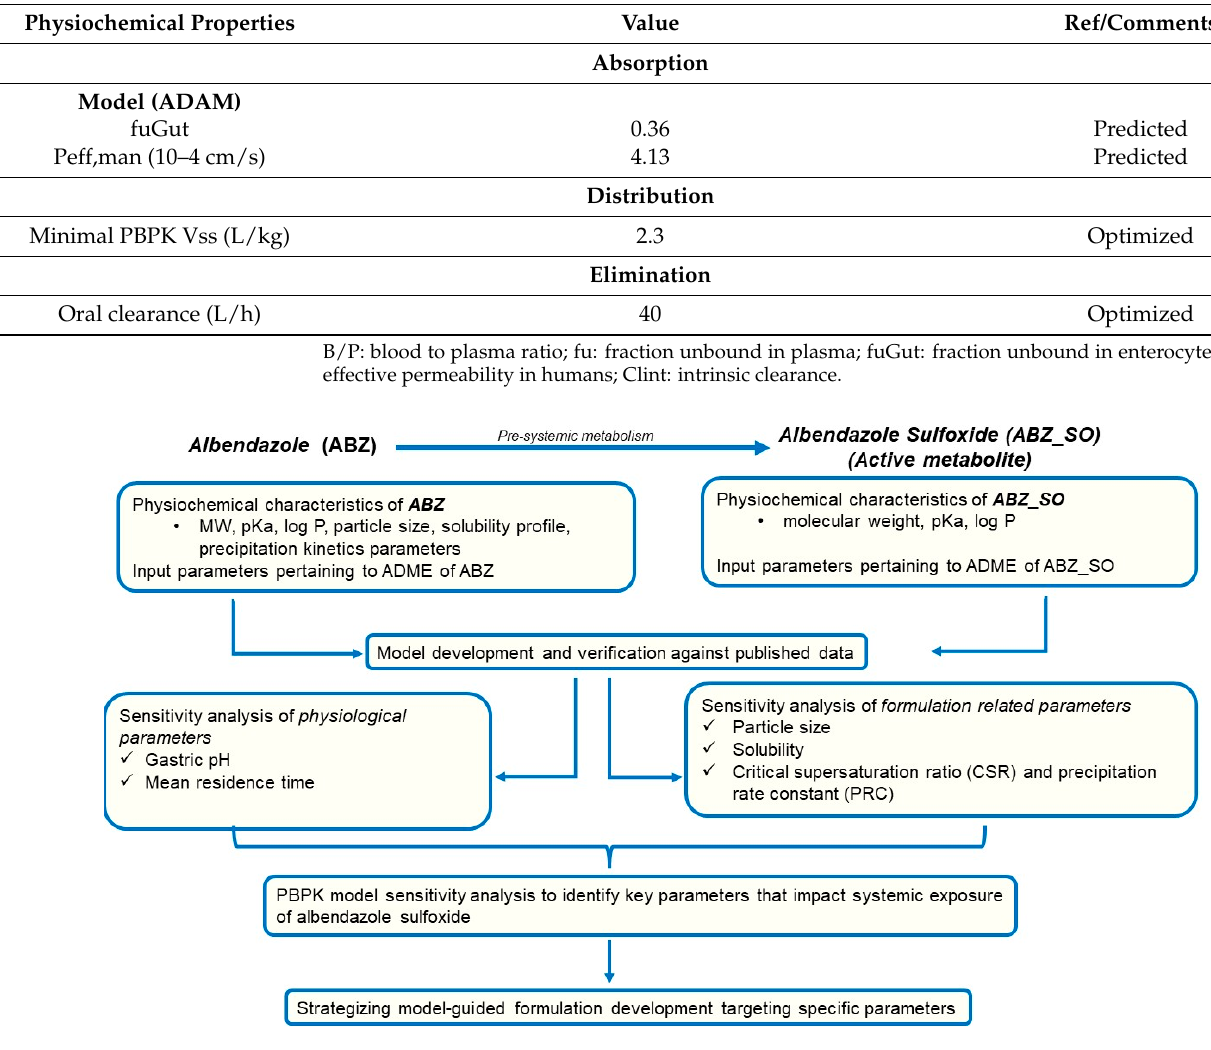
Figure 2. Flow chart for building a physiologically-based pharmacokinetic model for ABZ and ABZ_SO and strategizing formulation development.